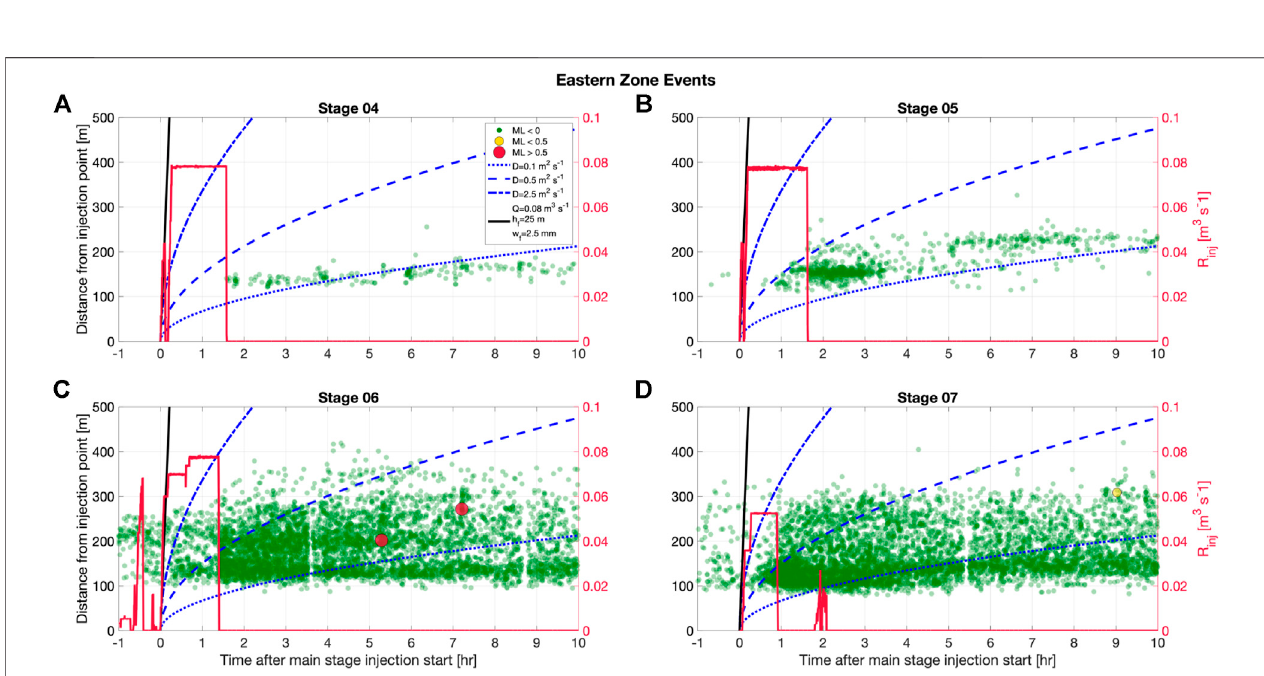
FIGURE 4 | Spatiotemporal evolution of microseismicity within the eastern clusters for each stage. The fi gure is formatted as in Figure 3 above. The delay in the onset of seismicity after injection in the eastern zone decreases with subsequent stages, indicative of permeability enhancement in the reservoir. Unlike during PNR-1z (Kettlety et al., 2020), the pattern of seismicity is more consistent with a r ∝ t 0 . 5 relationship i.e., diffusion of increased pore pressure.